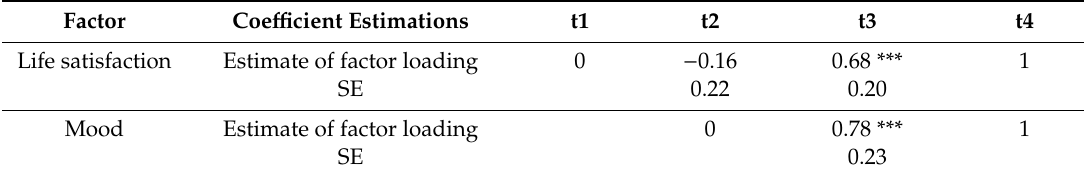
Table 3. Factor Loadings and Standard Errors (SE) of the Slope Factor for the General Development Model. Factor Coe ffi cient Estimations t1 t2 t3 t4 Estimate of factor loading 0 − 0.16 0.68 *** 1 SE 0.22 0.20 Estimate of factor loading 0 0.78